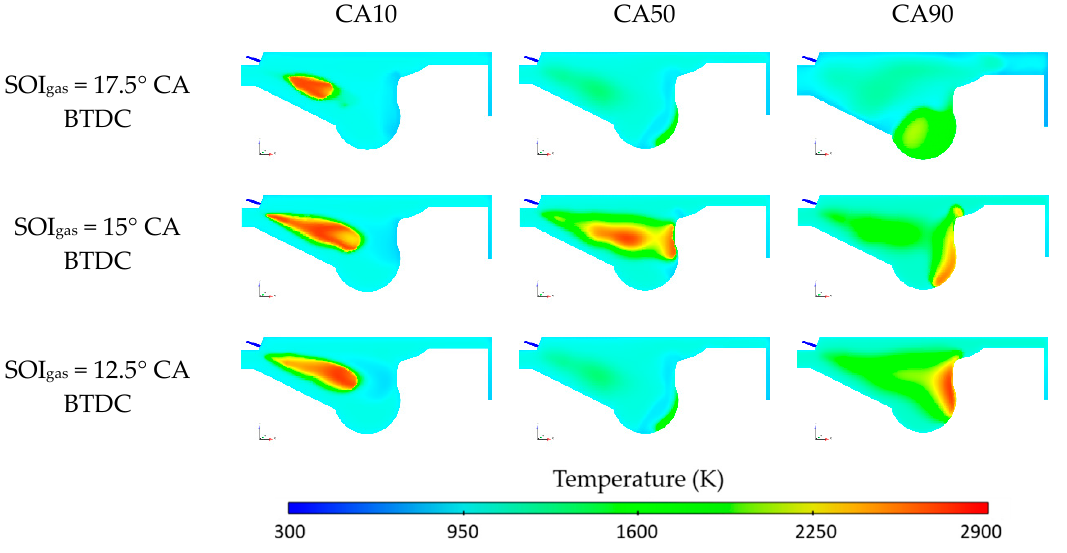
Figure 16. Average temperature cloud chart in the cylinder.